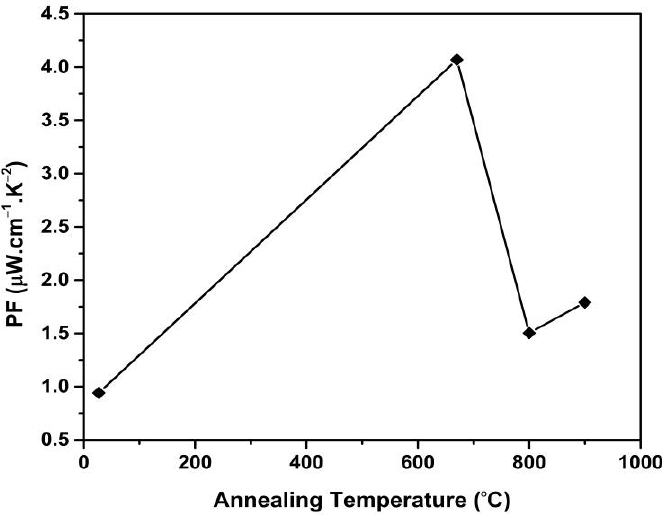
Figure 9. Annealing temperature dependent power factor (PF) of SiGe thin films.